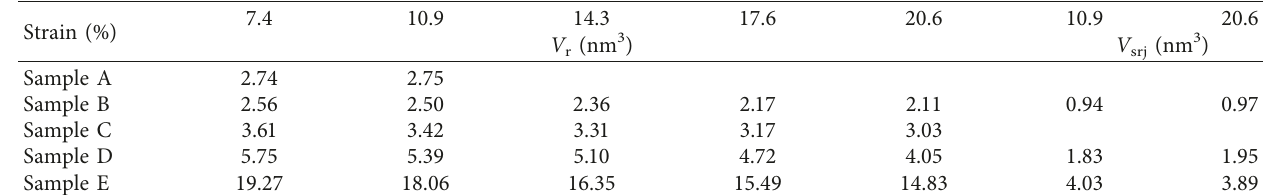
Table 1: Activation volumes of specimens of neat PU.